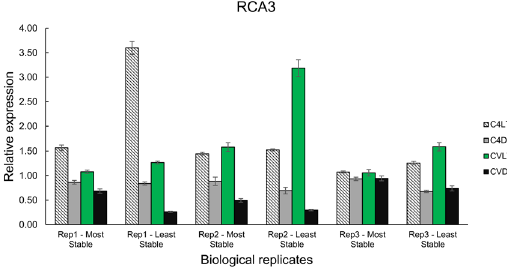
Figure 5. Relative expression levels of the RuBisCO activase gene RCA3 in two M . acuminata genotypes using the most ( UBQ2 and RAN ) and least ( α -TUB and ACT1pp1 ) stable pair of reference genes. RT-qPCR was performed in three biological replicates of light and dark treated leaf samples. Calcutta 4 (C4), Cavendish Grande Naine (CV), Light (LT) and Dark (DK). Bars represent the standard error ( ± SE) calculated for three technical